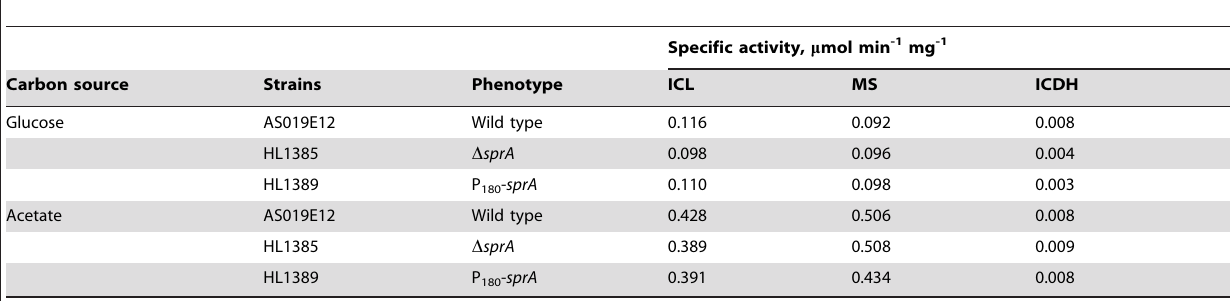
Table 2. Enzyme activities of isocitrate lyase (ICL), malate synthase (MS), and isocitrate dehydrogenase (ICDH) in cell extracts of C. glutamicum cells a